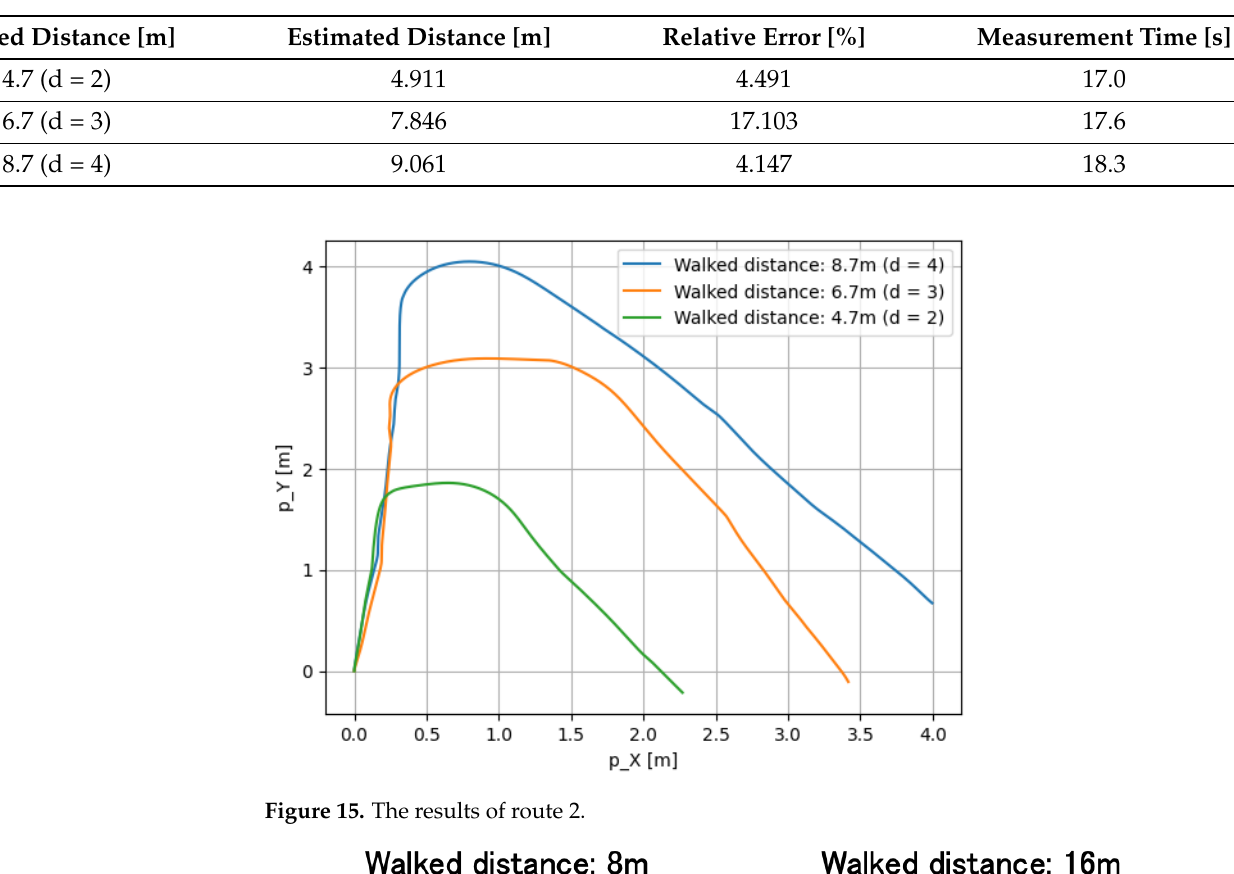
Table 3. The results of route 2.